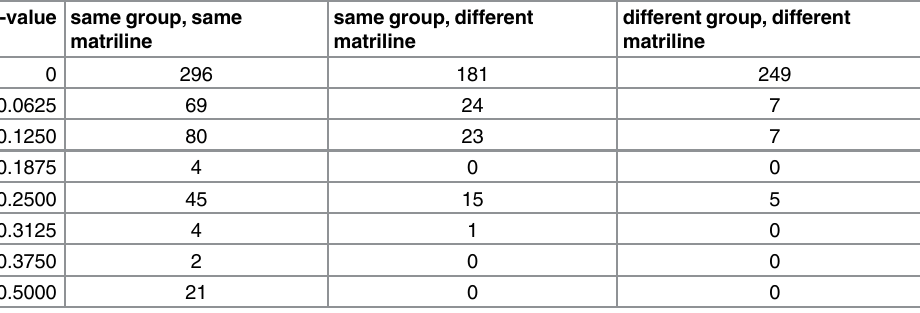
Table 1. Number of dyads with respective relatedness values in the three defined categories. r-value same group, same matriline